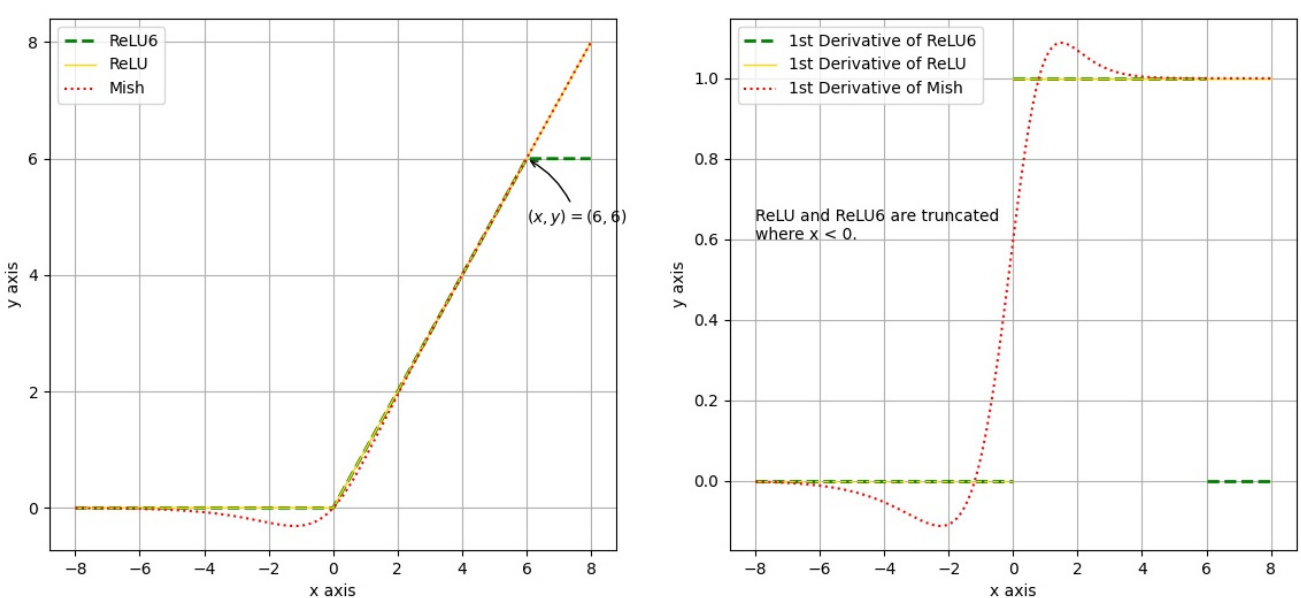
Figure 1. A comparison of ReLU, ReLU6 and Mish functions ( left ) and their 1st derivative function curves ( right ).